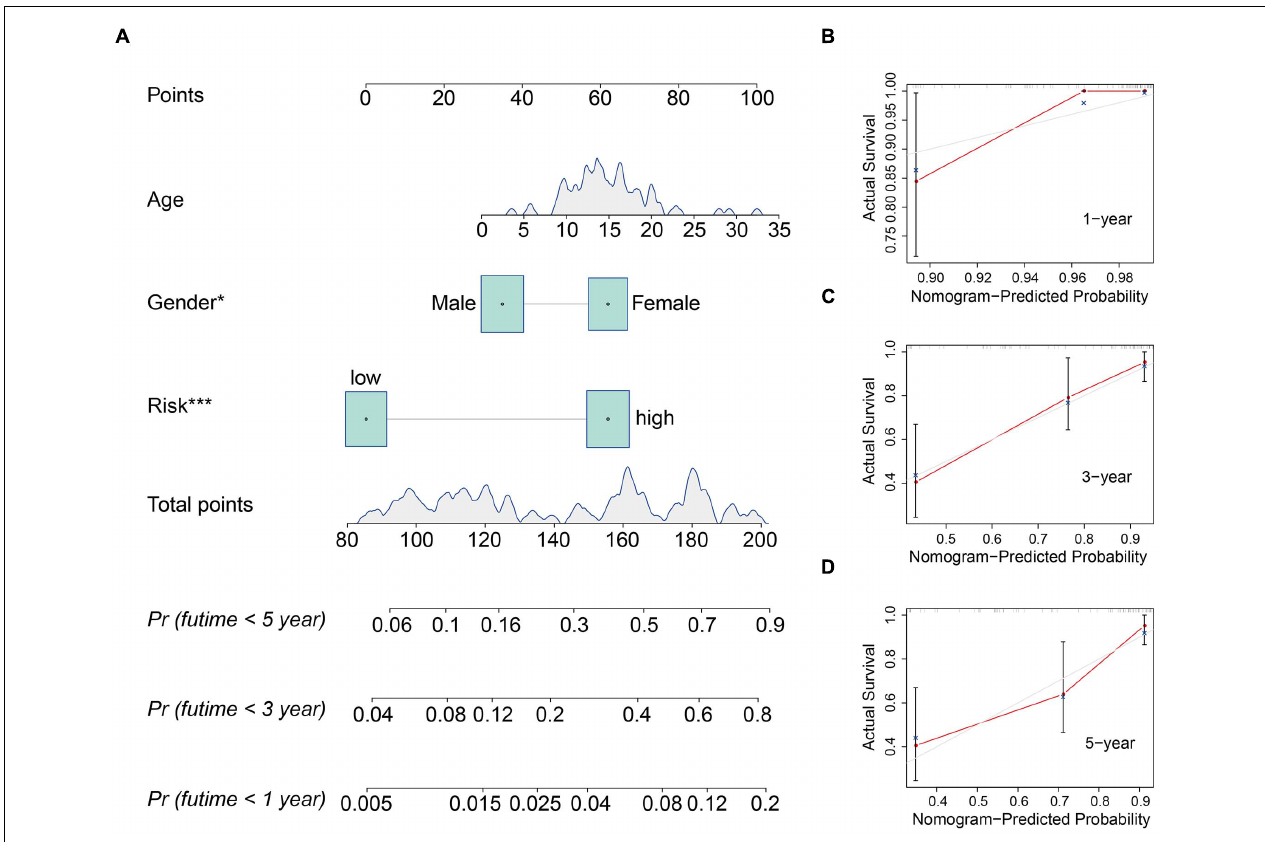
FIGURE 6 | Construction and validation of a nomogram in the TCGA osteosarcoma cohort. (A) The nomogram consists of age, gender, and risk score based on the six-MRG signature. (B–D) The calibration curve for internal validation of the nomogram for estimating the survival of osteosarcoma patients at 1, 3, and 5